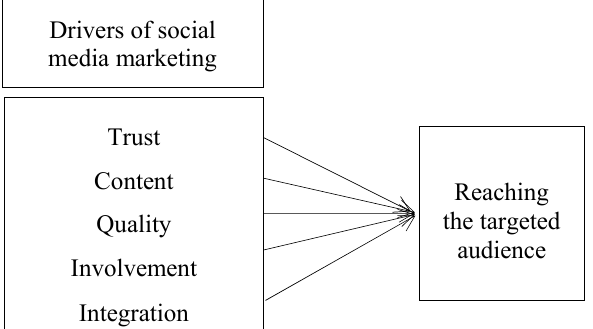
Fig.1. Model of the